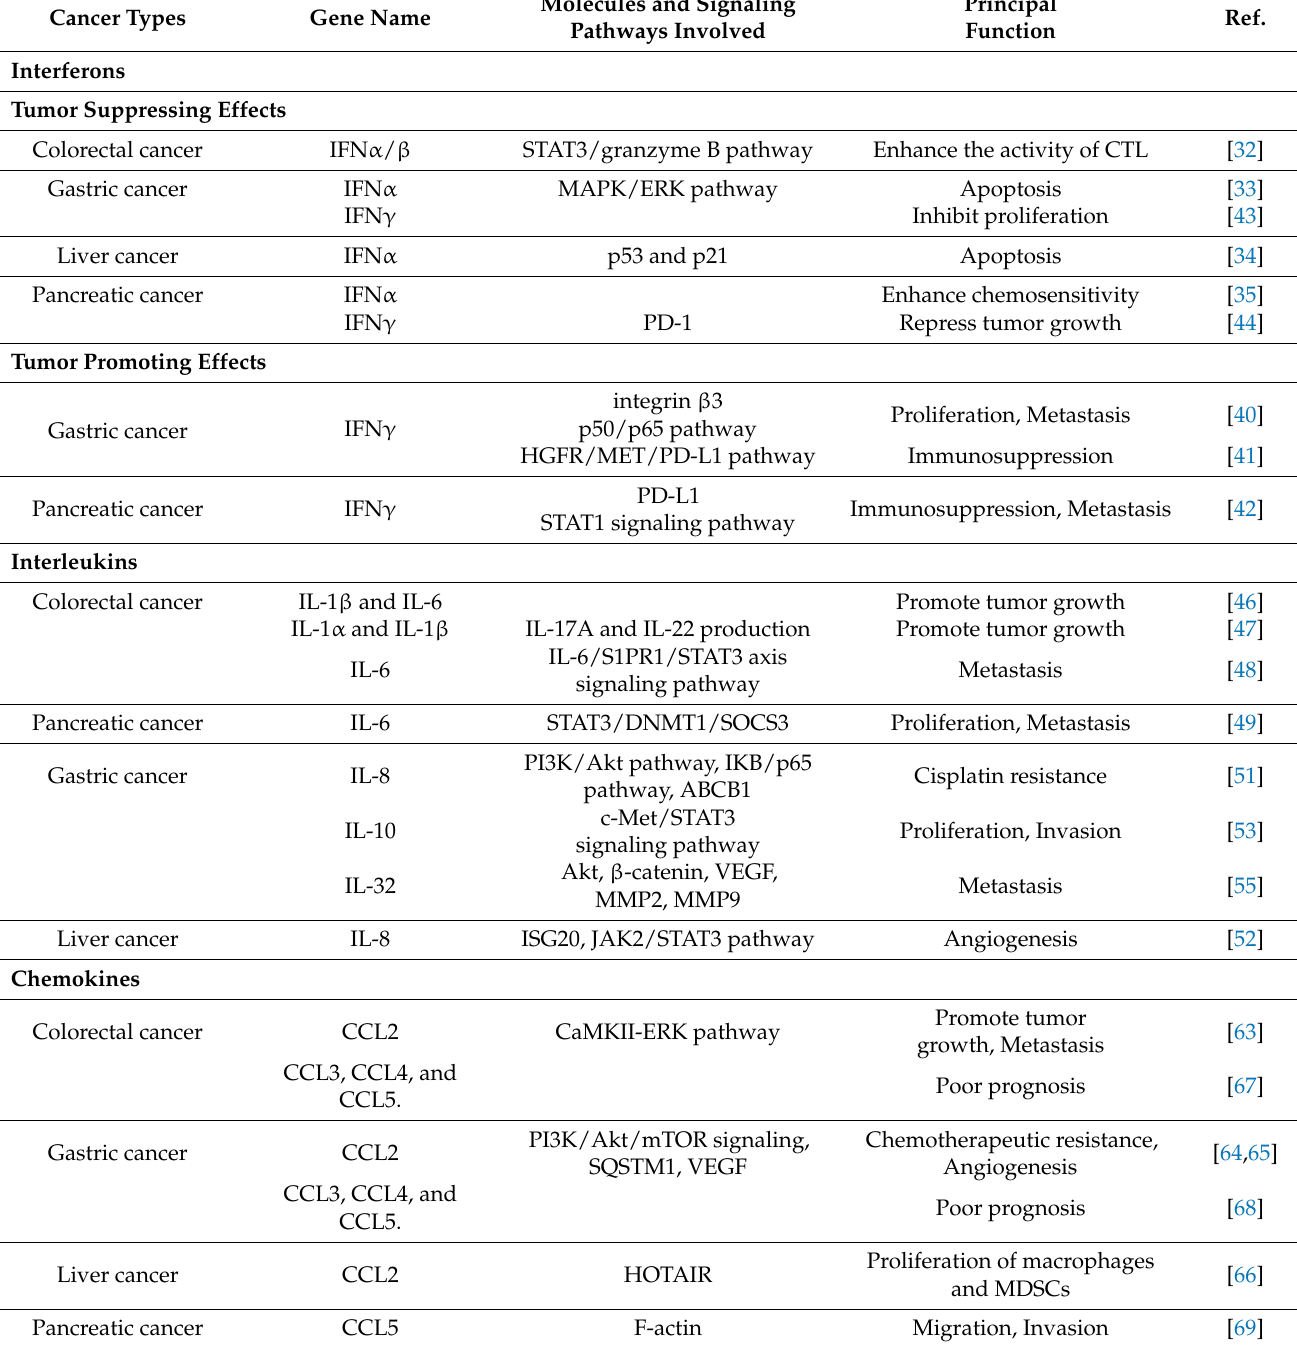
Table 1. Inflammatory cytokines and their potential mechanisms in gastrointestinal